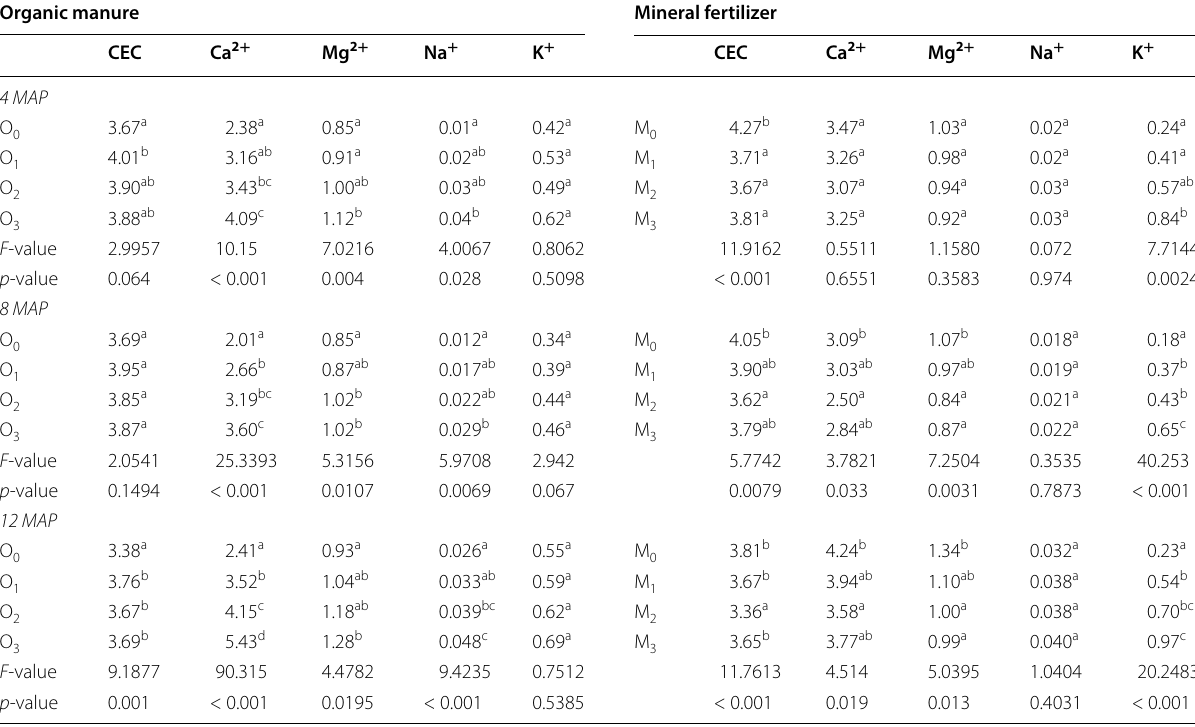
Means in the same column with the same letter are not significantly different. MAP months after planting. O 0 chicken manure, O